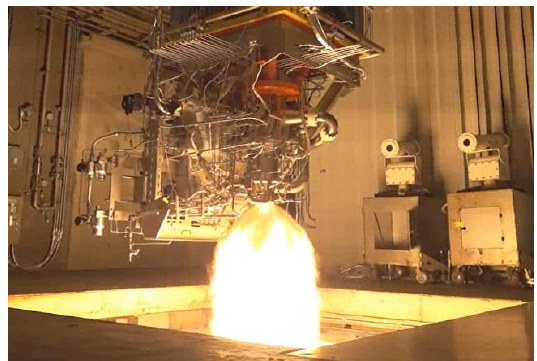
Figure 9. Combustion test of 9-Tf staged-combustion cycle engine.